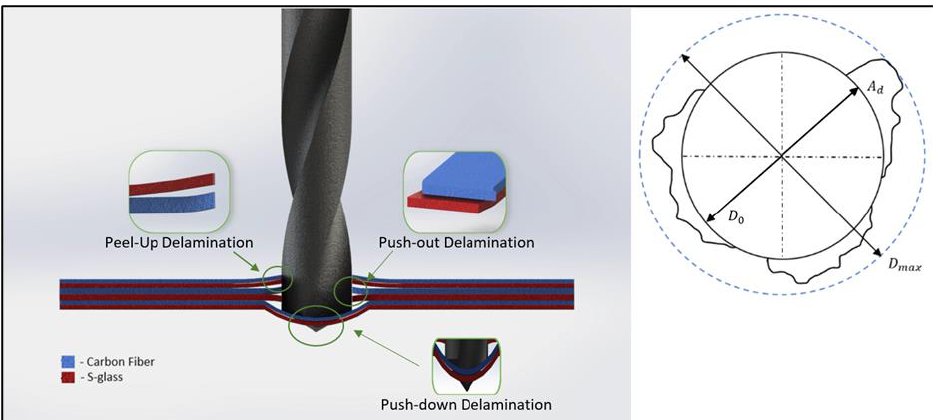
Figure 6. Delamination during drilling and schematic illustration of geometric parameters for drilling investigation.